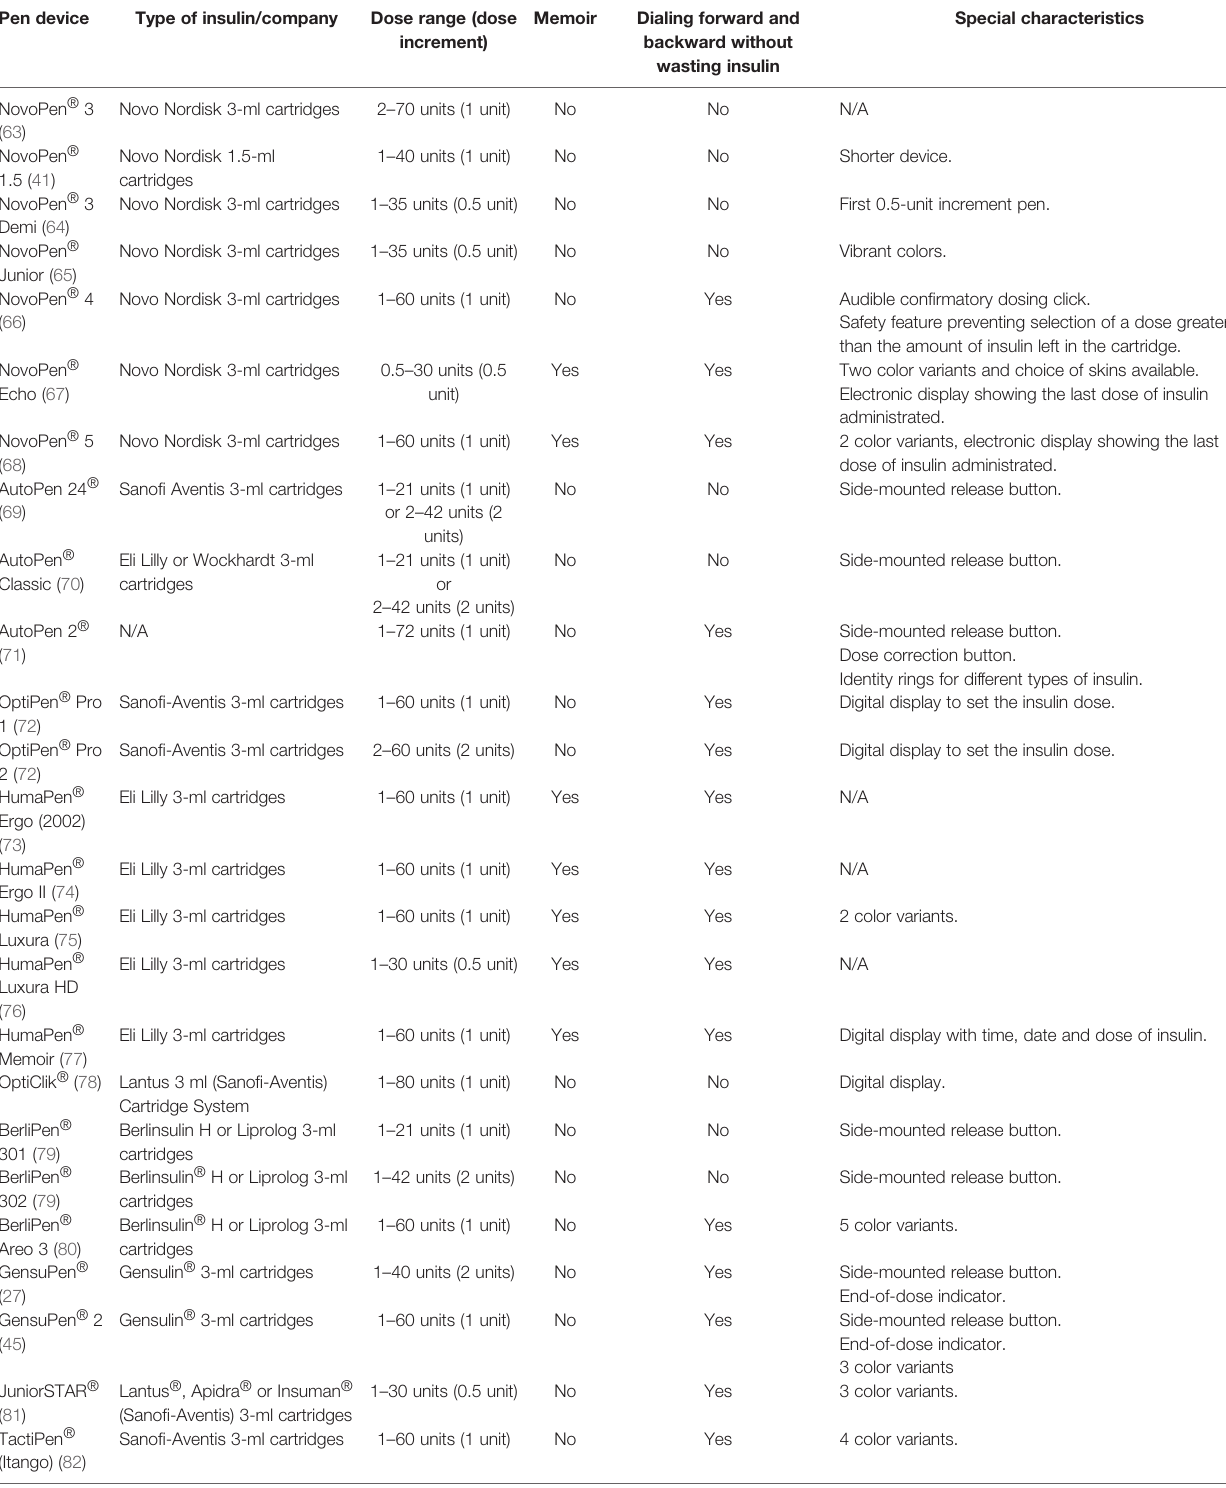
TABLE 2 | Characteristics of reusable insulin